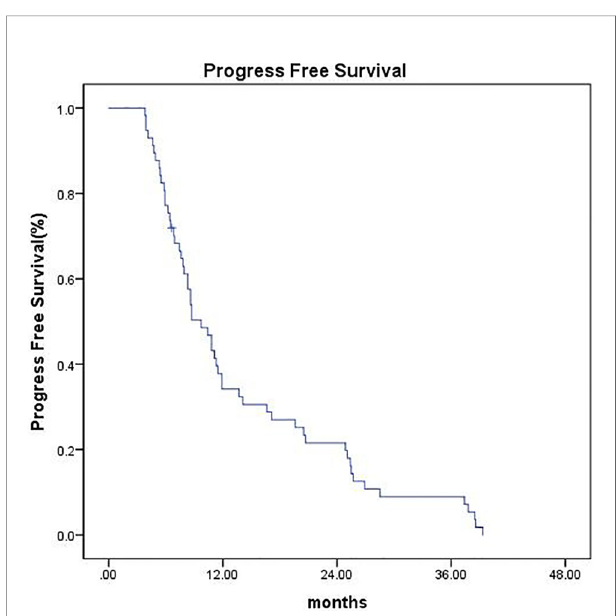
FIGURE 3 | Kaplan – Meier estimates of